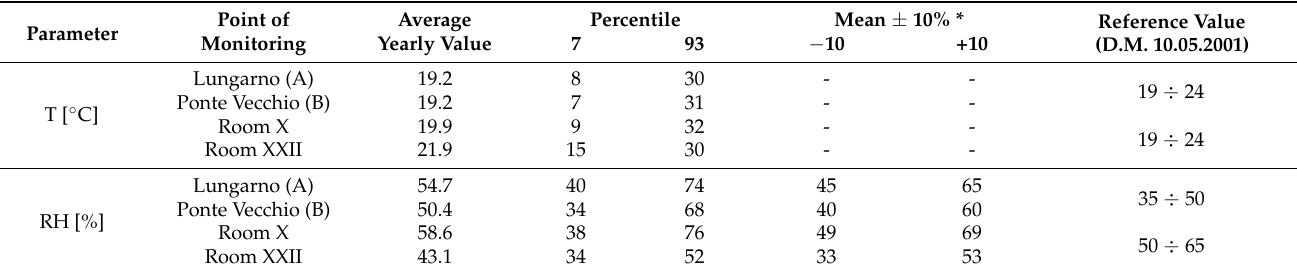
Table 6. Values of average T and RH by historical climate.